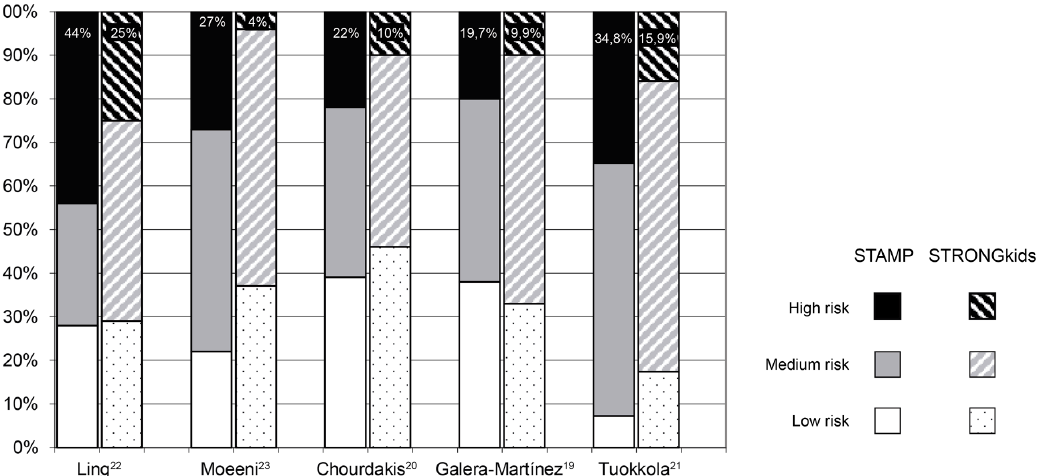
Figure 2. Distribution of nutritional risk in STAMP and STRONGkids in di ff erent published comparative studies. Percentages corresponding to patients classified as high risk are shown in